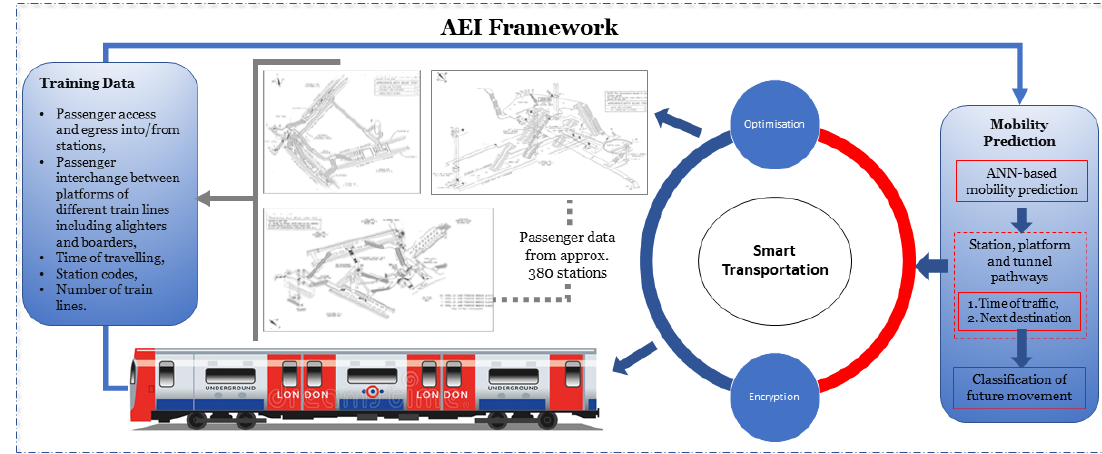
Figure 1. Access, Egress, and Interchange (AEI) Framework with data collection points from approximately 380